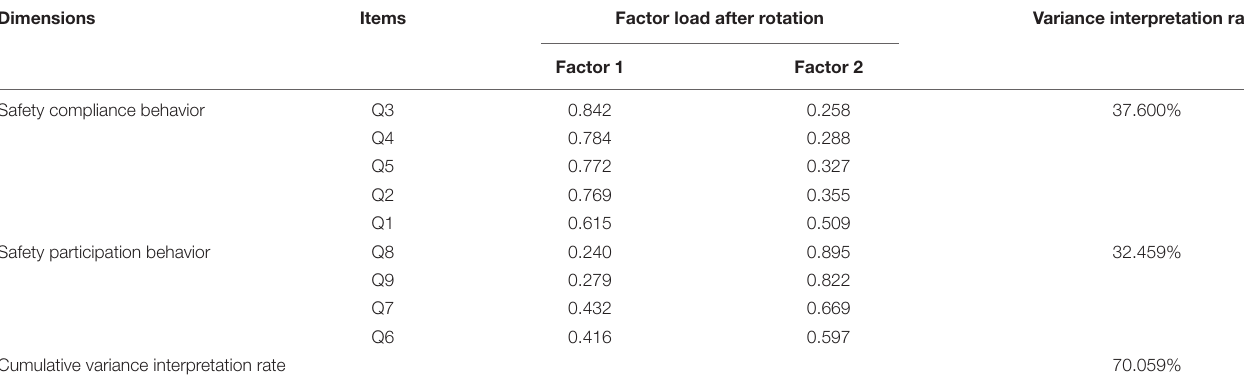
TABLE 3 | Factor load matrix after rotation: safety behavior scale.